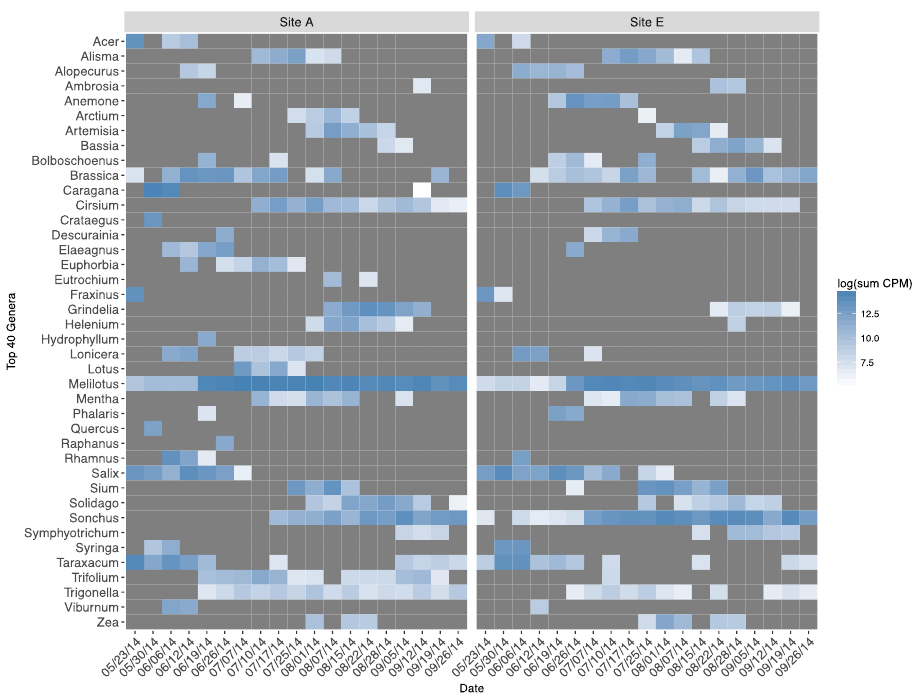
Figure 5. Top 40 plant genera assigned (log sum counts-per-million from all colonies within an apiary and date), 2014. Table 2. Spearman’s rho ranked correlation of taxa assigned via DNA sequencing between apiaries over time. Pollen counts-per-million among all colonies within an apiary were ranked on each sample